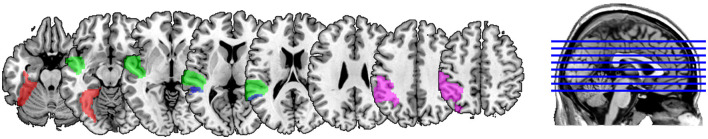
Anatomical extents of the atlas-based anatomical definitions of the masks used to constrain region of interest (ROI) definitions for fusiform gyrus (FG; red), superior temporal gyrus (STG; green), superior temporal sulcus (STS; blue) and inferior parietal lobule (IPL; magenta). Voxels falling within each of these regions that showed greater activity for lexical trials vs. baseline for a participant were included in that participant’s ROI for that anatomical label.